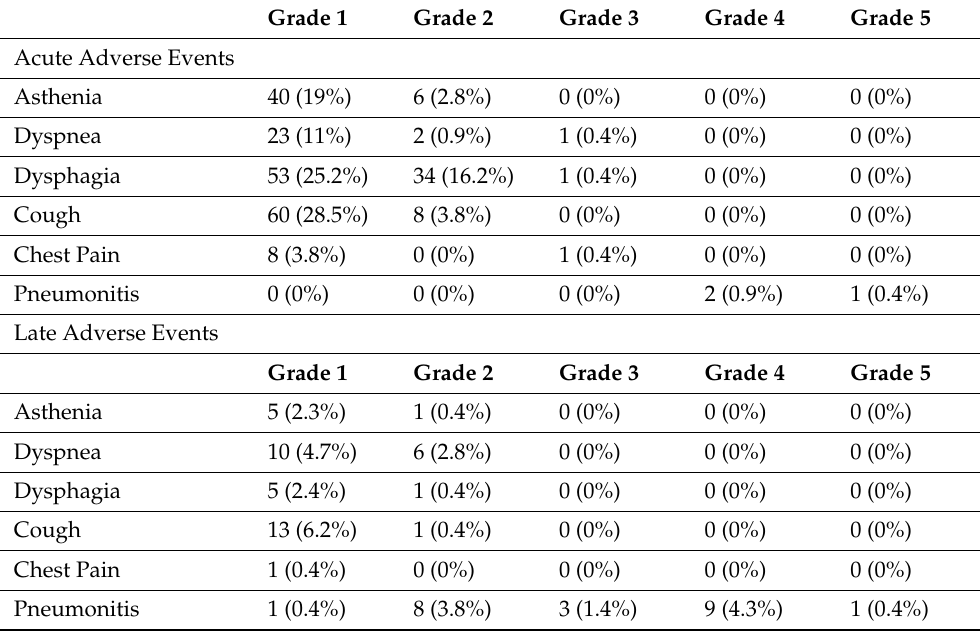
Table 3. Treatment-related